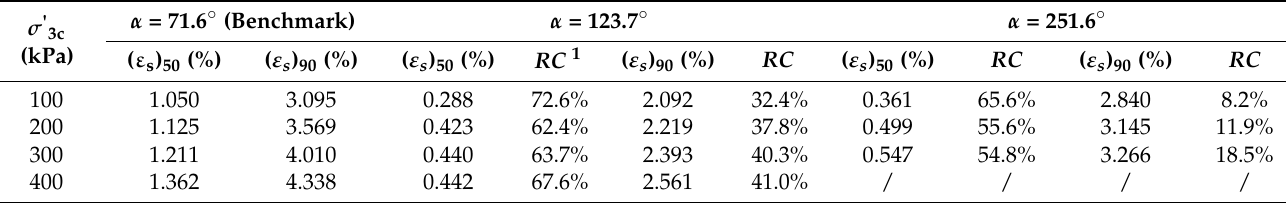
Table 5. Summary of ( ε s ) 50 and ( ε s ) 90 under decreasing- p’ stress